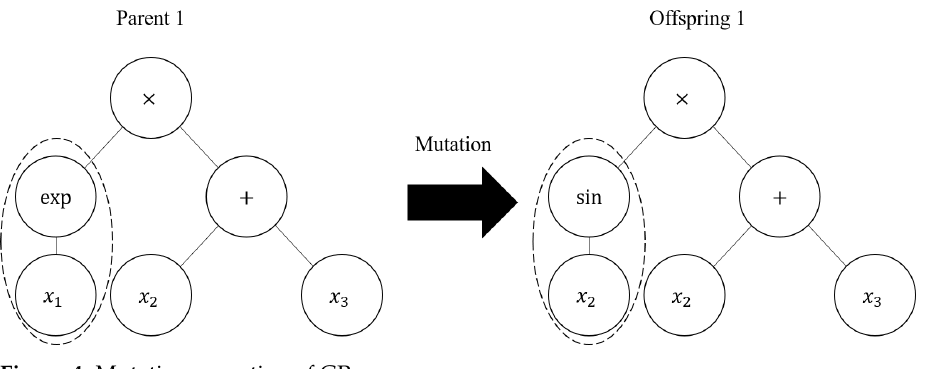
Figure 4. Mutation operation of